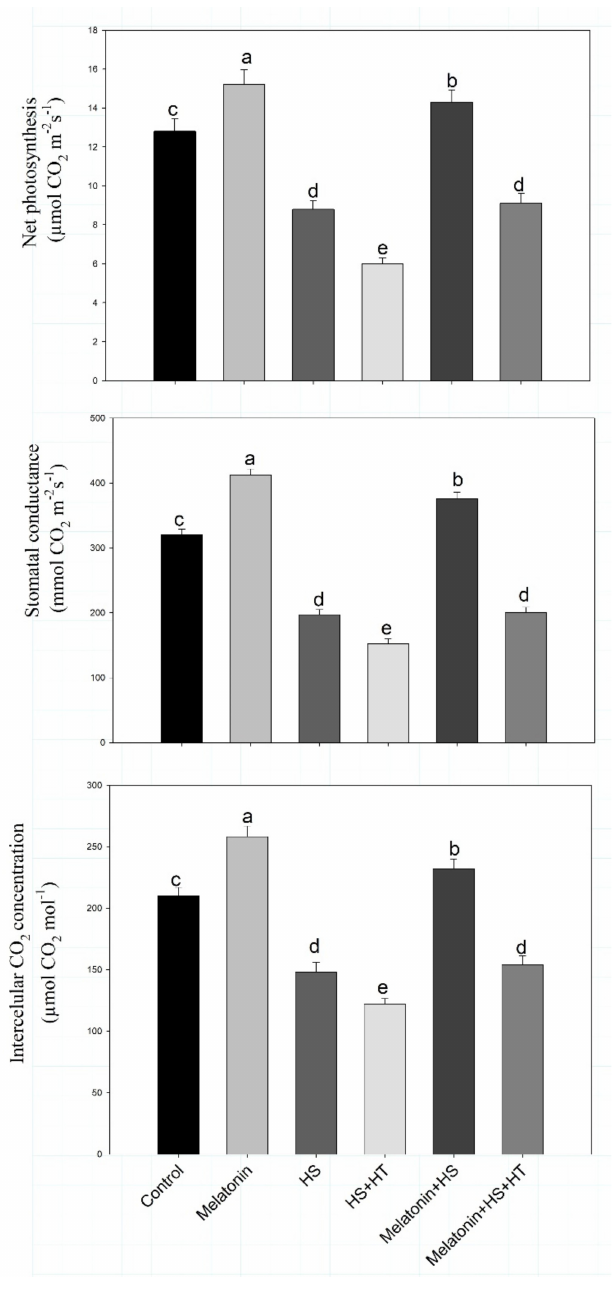
Figure 2. Net photosynthesis, intercellular CO 2 concentration, stomatal conductance of wheat ( Triticum aestivum L. var. WH 542) leaves at 30 days after sowing (DAS). Plants were treated with melatonin (100 µ M) and/or HT (100 µ M) in the presence (40 ◦ C) or absence (25 ◦ C) of heat stress. Data are presented as means ± SE ( n = 4). Data followed by the same letter are not significantly different by LSD test at p < 0.05. HS, heat stress; HT;